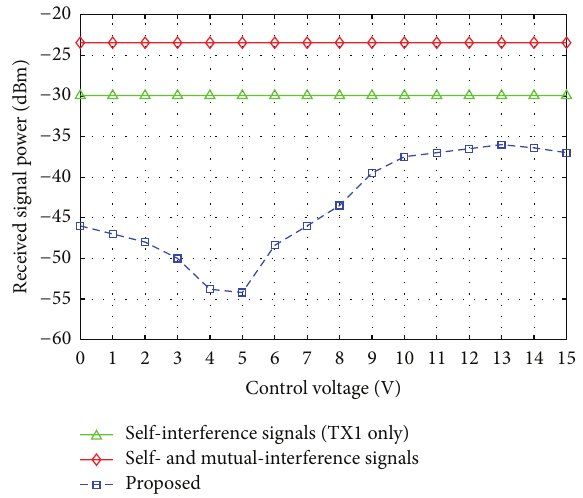
Figure 13: The received signal power of interference signals at